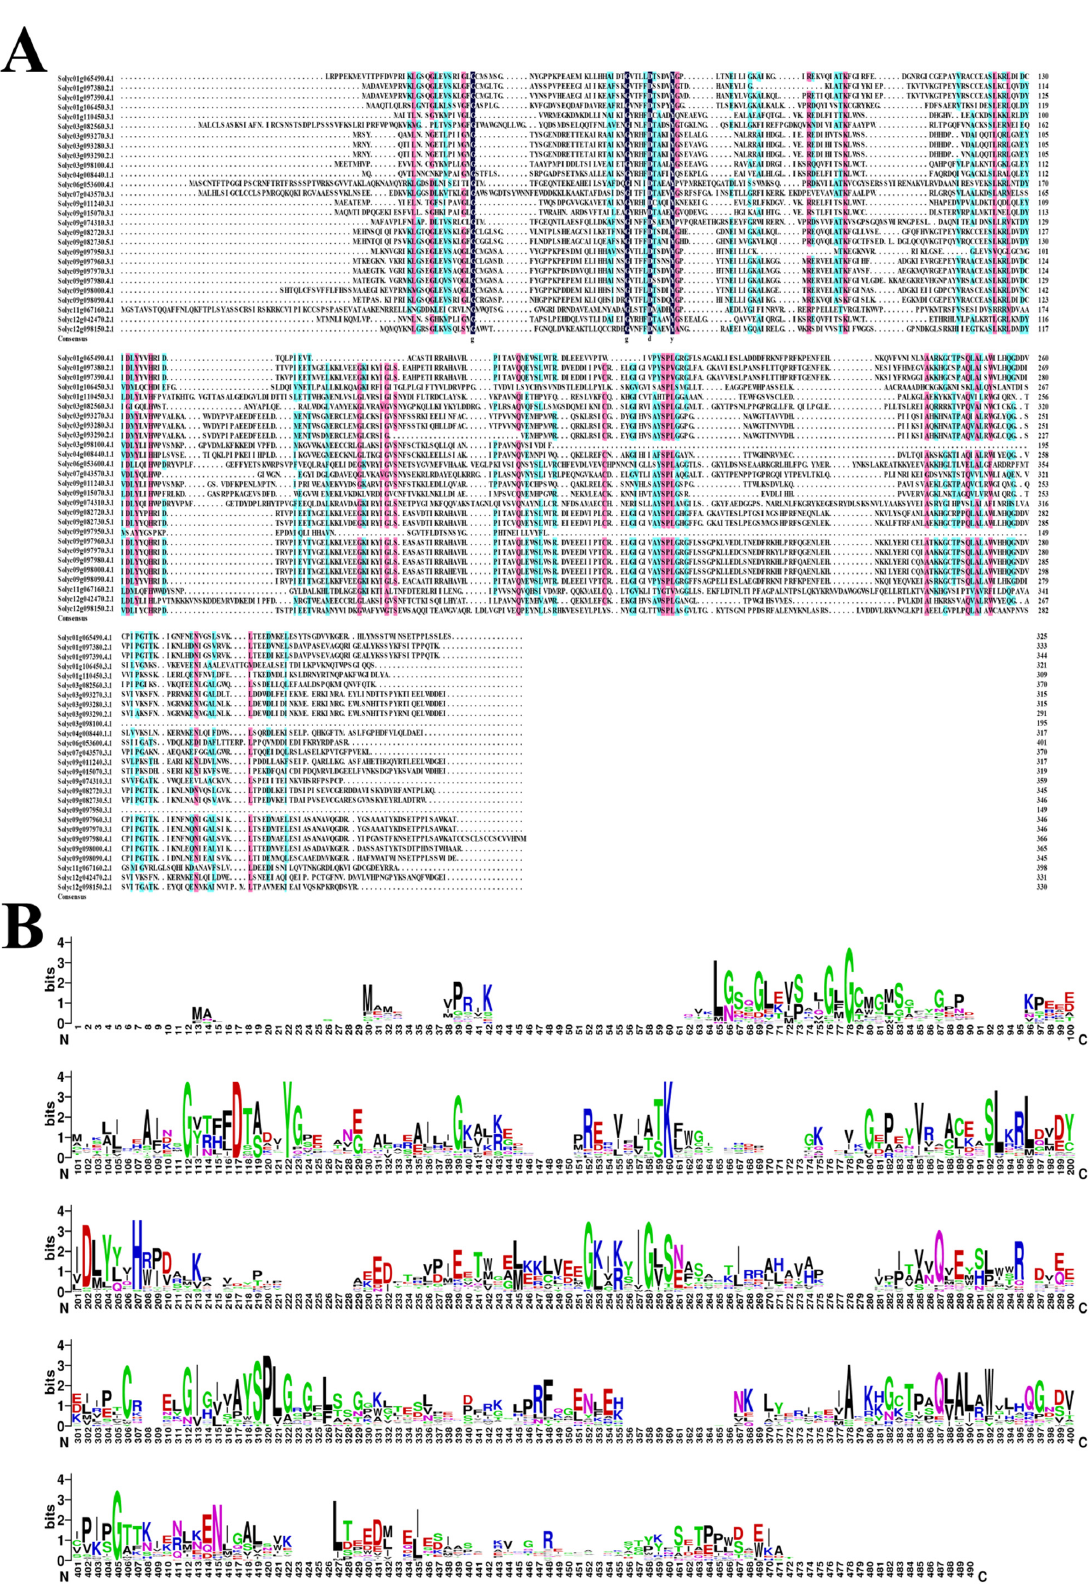
Figure 3. Multiple protein sequence alignments of the SlAKR family in Solanum lycopersicum . ( A ) Multiple sequence alignment of SlAKRs. Dark blue represented homology level of 100%, ≥ 75%, and ≥ 50% with the colors of blue and, pink, respectively; ( B ) Sequence LOGO of AKRs in Solanum lycopersicum on the basis of protein